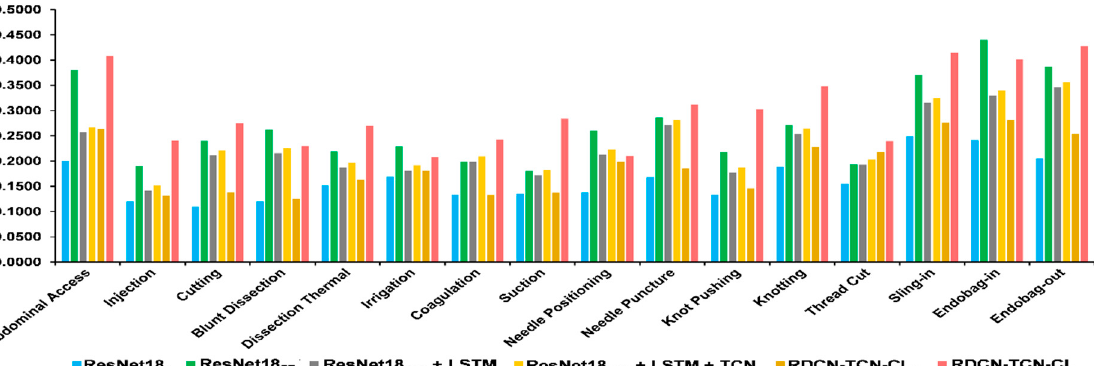
Figure 7. Class ‐ wise comparison of Surgical Actions 160 between RDCN ‐ TCN ‐ CL and other net ‐ Figure 7. Class-wise comparison of Surgical Actions 160 between RDCN − TCN − CL and other work architectures, in the terms of retrieval performance (mAP averaged over 10 splits). network architectures, in the terms of retrieval performance (mAP averaged over 10